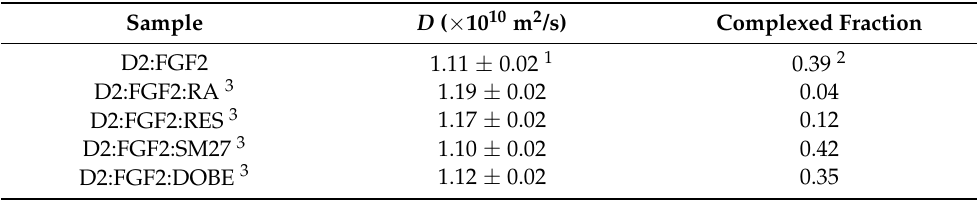
Table 1. Diffusion coefficient of protein species in the presence of inhibitors.